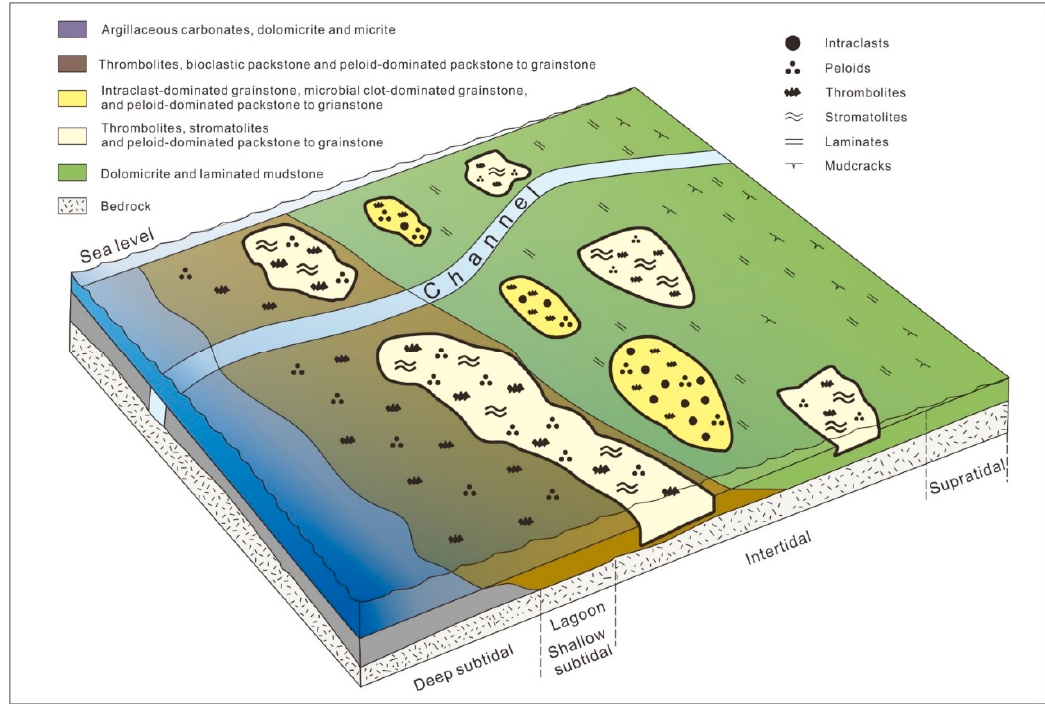
Figure 12. Schematic diagram of the sedimentary environments of the Leikoupo Formation.